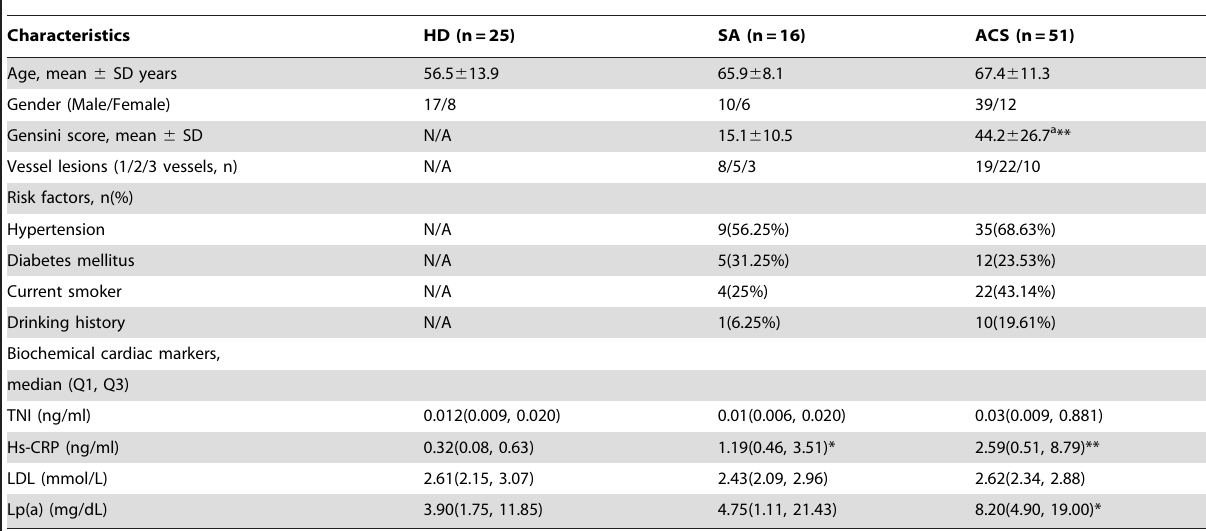
Table 1. Clinical characteristics of the groups.